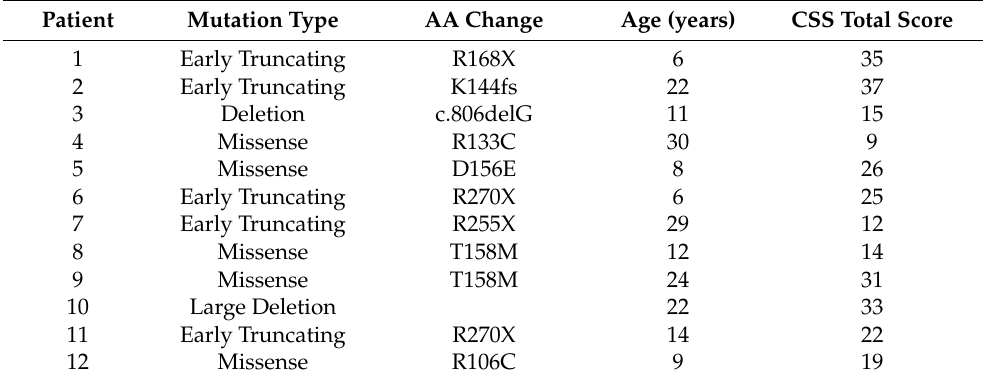
Table 1. Clinical characteristics of Rett syndrome (RTT) patients included in this study. AA = aminoacids; CSS = Clinical Severity